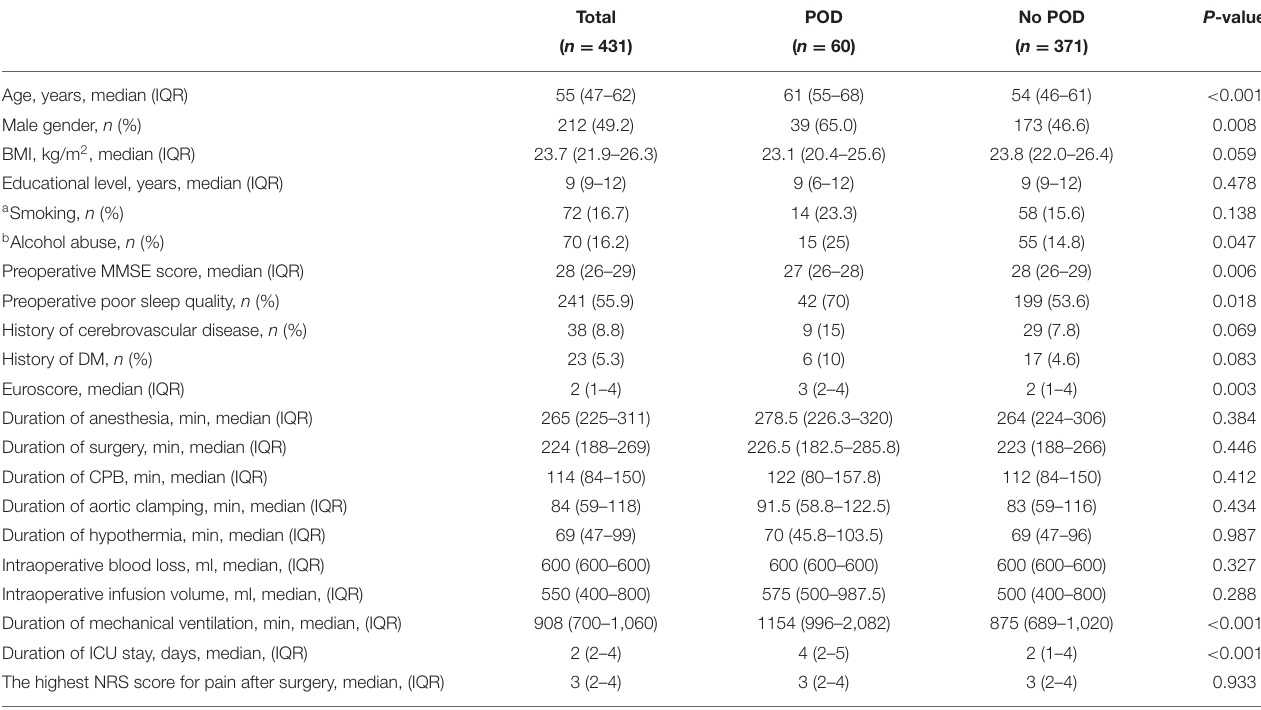
TABLE 1 | Univariate analyses of baseline characteristics and risk factors according to